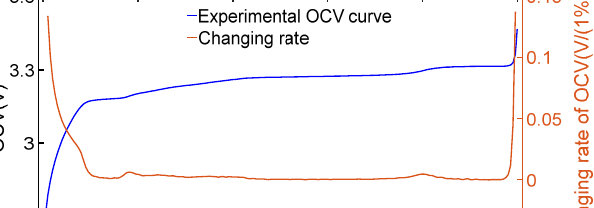
By approximately calculating the changing rate of OCV with SOC, it is obvious that the changing rate of the OCV curve has bumps around 20% SOC and 80% SOC.